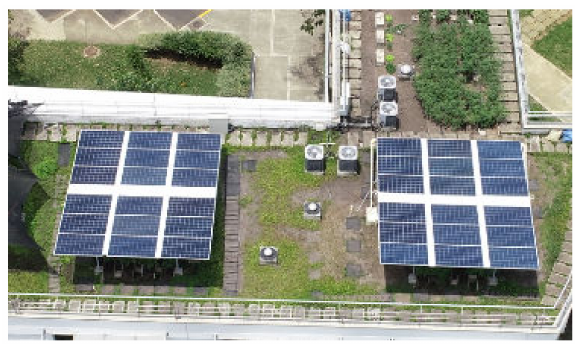
Figure 2. Studied PV system.